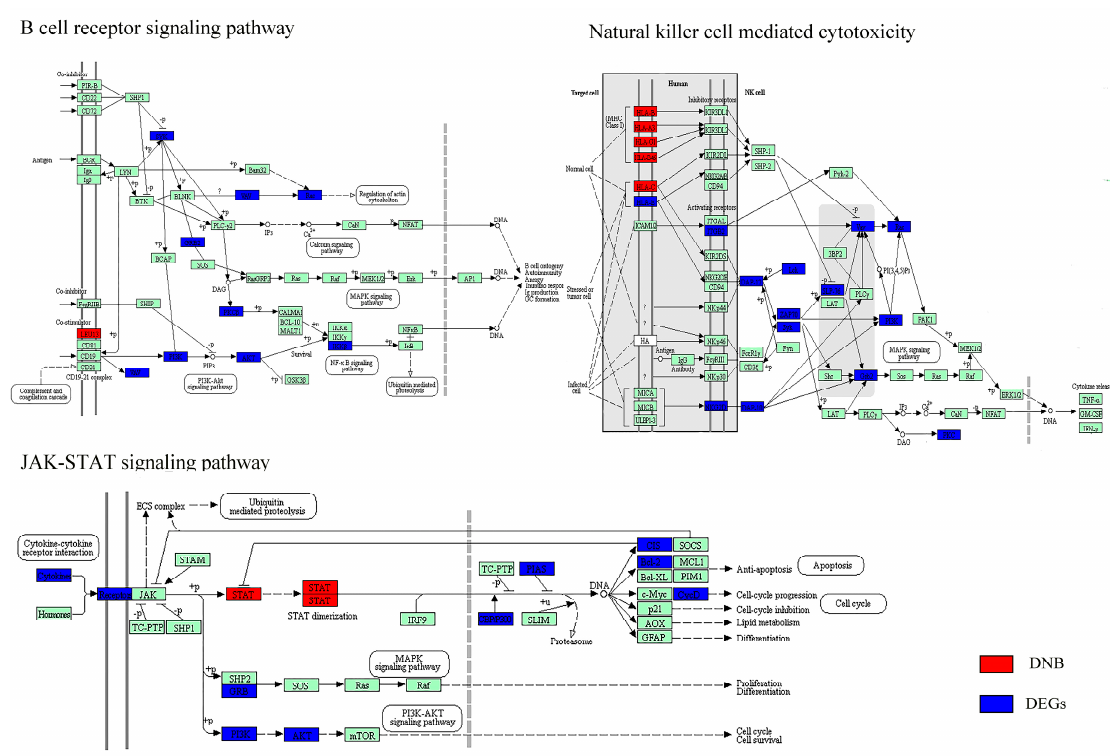
Figure 4. Hepatocellular carcinoma-related biological pathways with both DNB members and DEGs. DNB members are placed at relatively important positions in the pathways (e.g., transciption factors, receptors, and upstream regulators). DNB: dynamic network biomarkers; DEGs: differentially expressed genes.